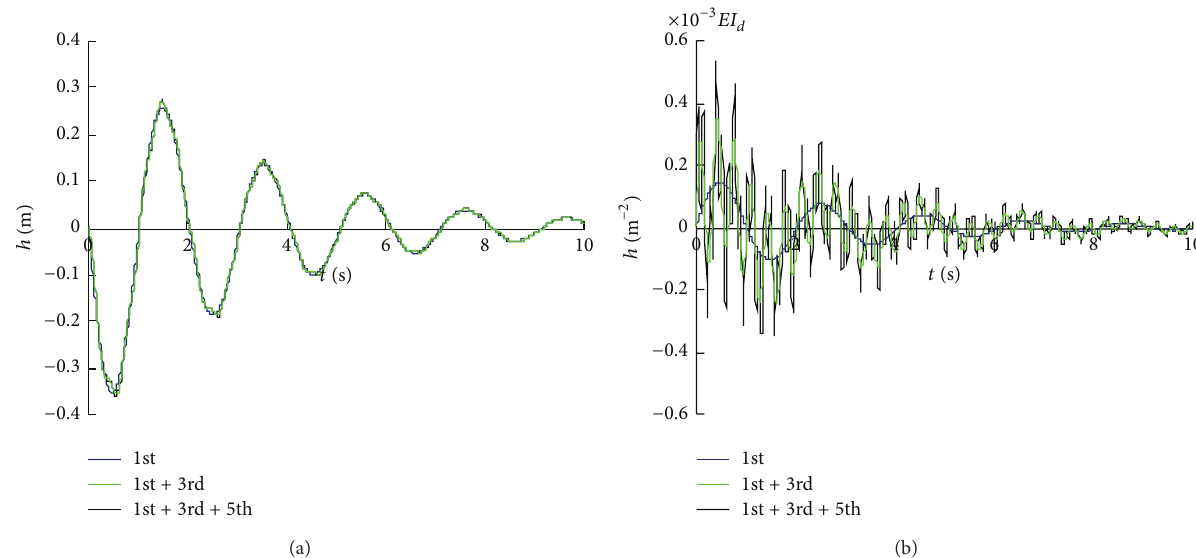
Figure 4: Response to impulsive loading ( ℎ ) versus time ( 𝑡 ) in terms of (a) midspan transverse displacement and (b) abutment reactions.